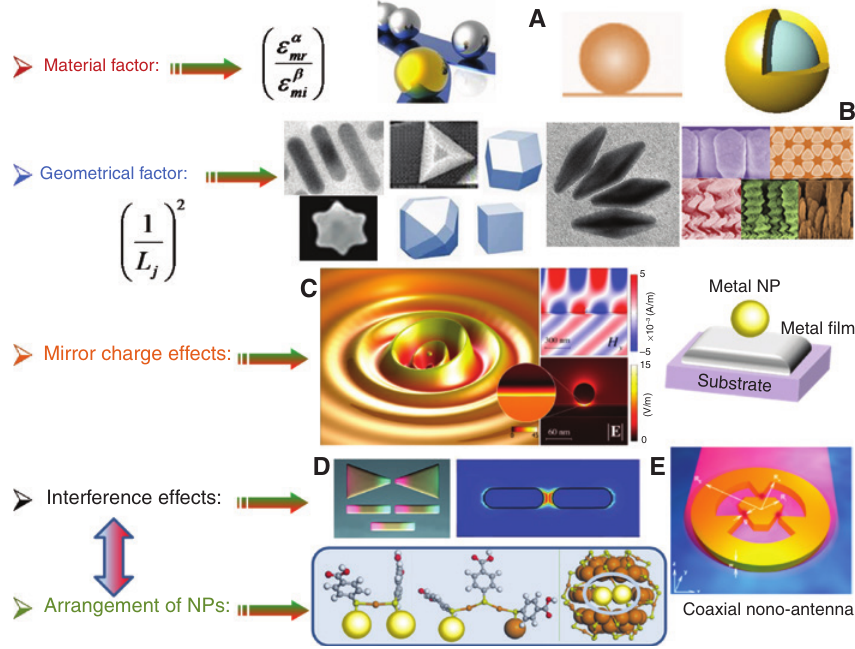
Figure 3: Several factors affecting field enhancement upon plasmon excitation. All parts A–E correspond to the titles on the left respectively. Designated figures were reproduced with permission from the